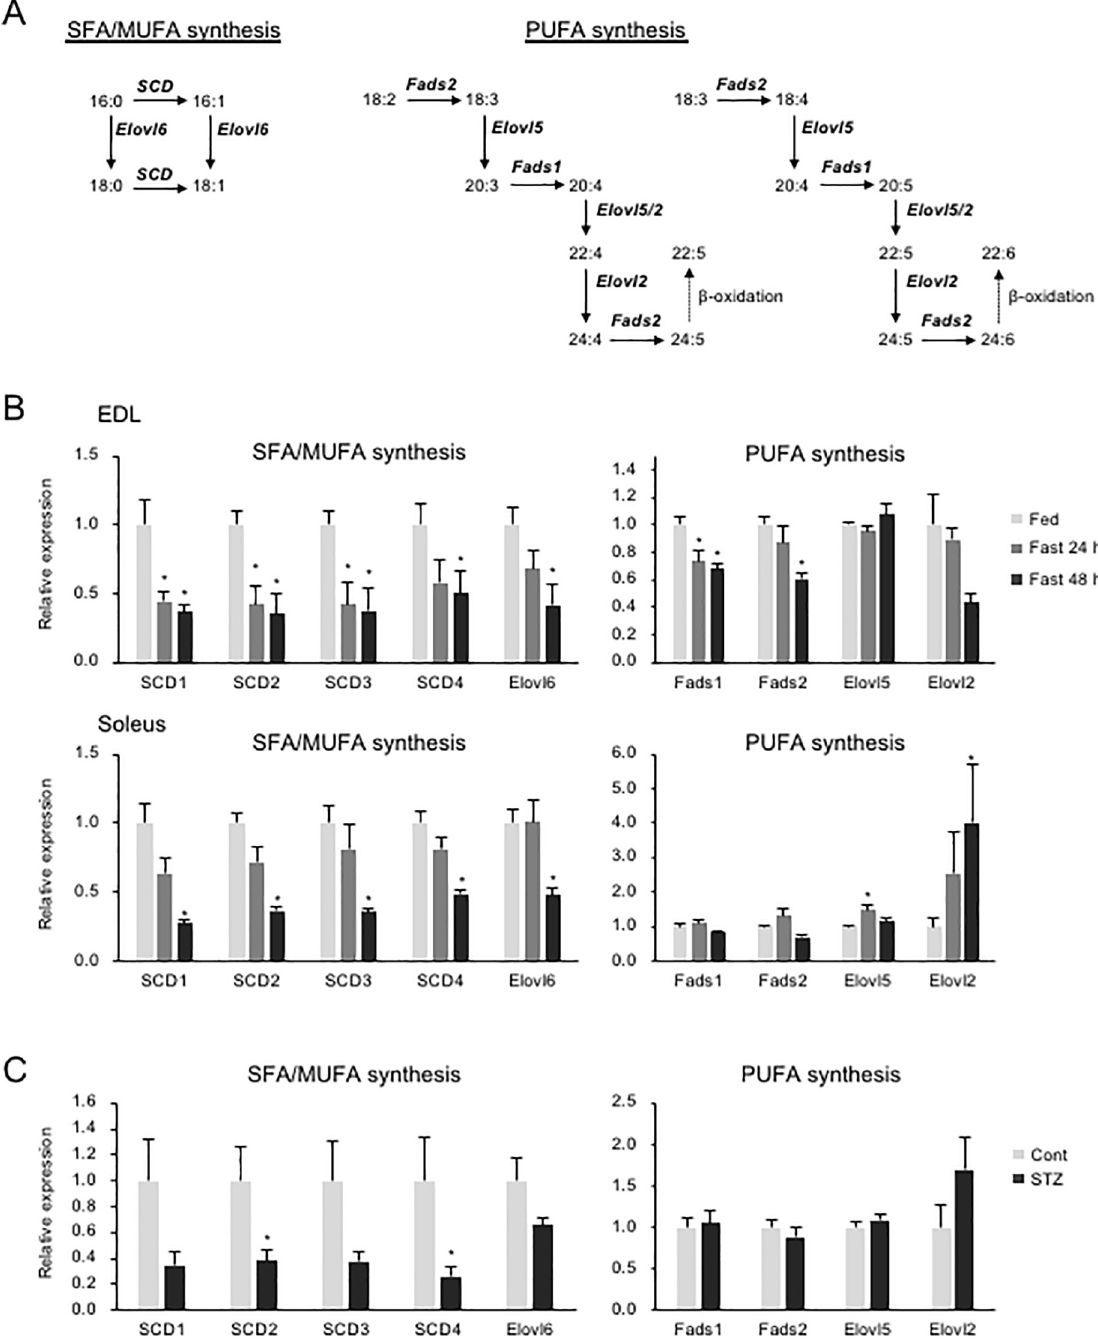
Fig 4. Gene expression levels of desaturases and elongases are affected by fasting and insulin. (A) Schematic representation of fatty acid synthesis. In SFA/MUFA synthesis, SCD and Elovl6 catalyze the addition of double bonds and carbon chain elongation, respectively. 18:2 and 18:3 are converted to the respective n-6 and n-3 PUFA series, ending with peroxisomal beta-oxidation. (B) mRNA expression of desaturases and elongases in EDL and soleus from ad lib feeding (Fed) and fasting (Fast) mice (n = 6–7). Values represent mean ± SE; � P < 0.05 (vs. Fed). (C) mRNA expression of desaturases and elongases in gastrocnemius from control (Cont) and STZ-injected (STZ) mice (n = 5–8). Values represent mean ± SE; � P < 0.05.